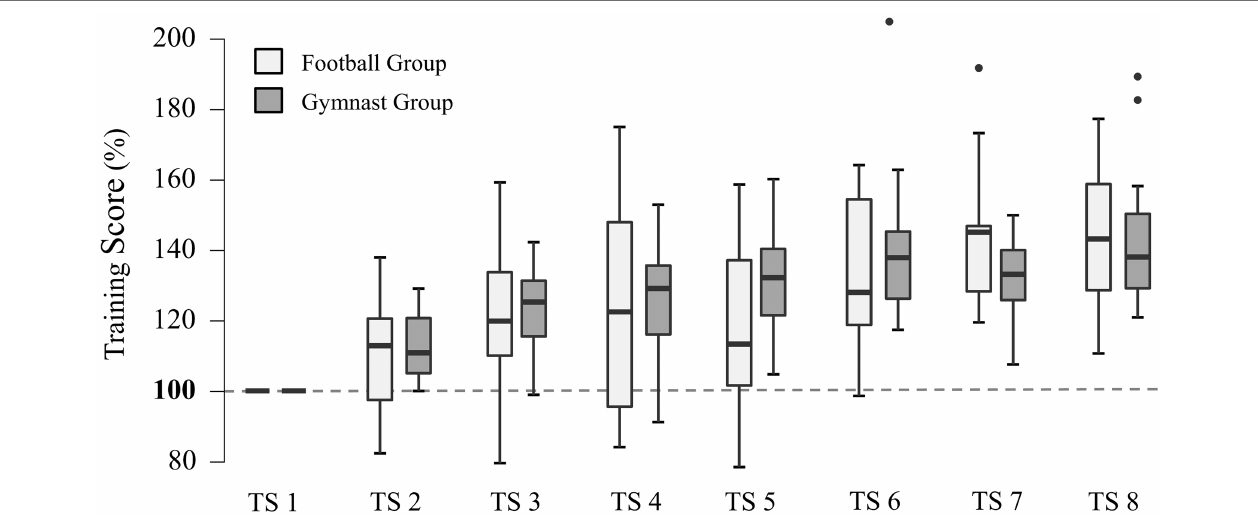
FIGURE 3 | Dynamic balance training results. Significant improvements in training scores of dynamic balance training using the challenge disk over eight training sessions (TS). All values were normalized to scores obtained during TS 1. For detailed pairwise post-hoc statistics please see Table 1